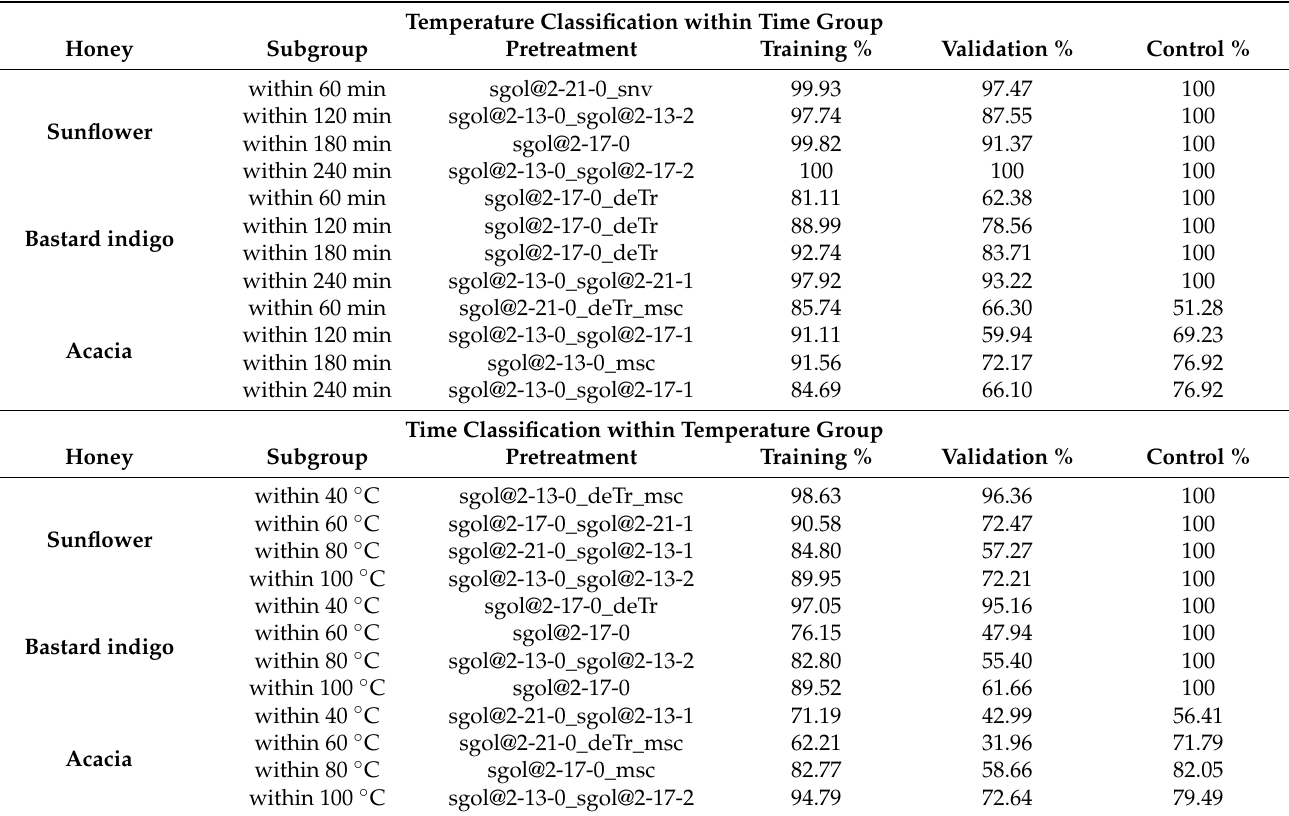
snv denotes standard normal variate; detr denotes